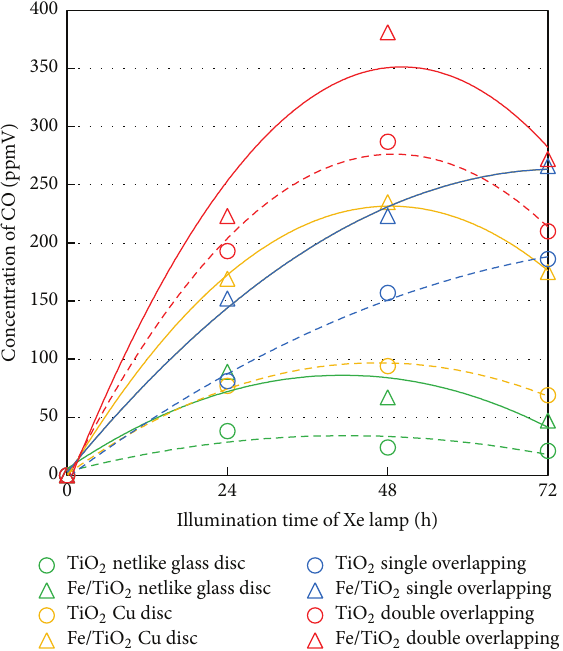
Figure 12: Comparison of concentrations of produced CO among photocatalysts coated on different base materials under the illumi- nation condition with UV light.